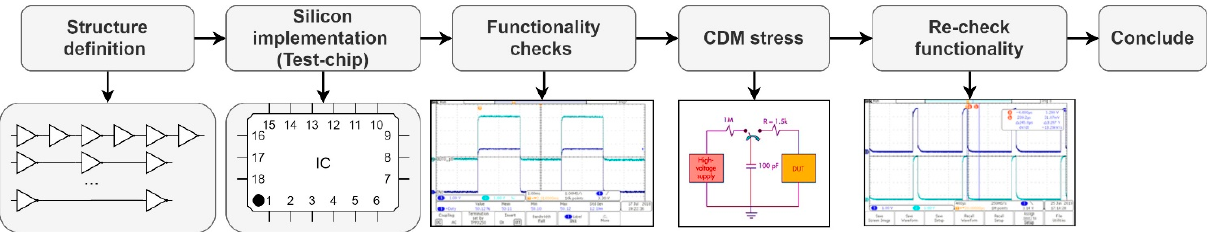
Figure 3. Methodology for maximum ground wire resistance definition while CDM protected.